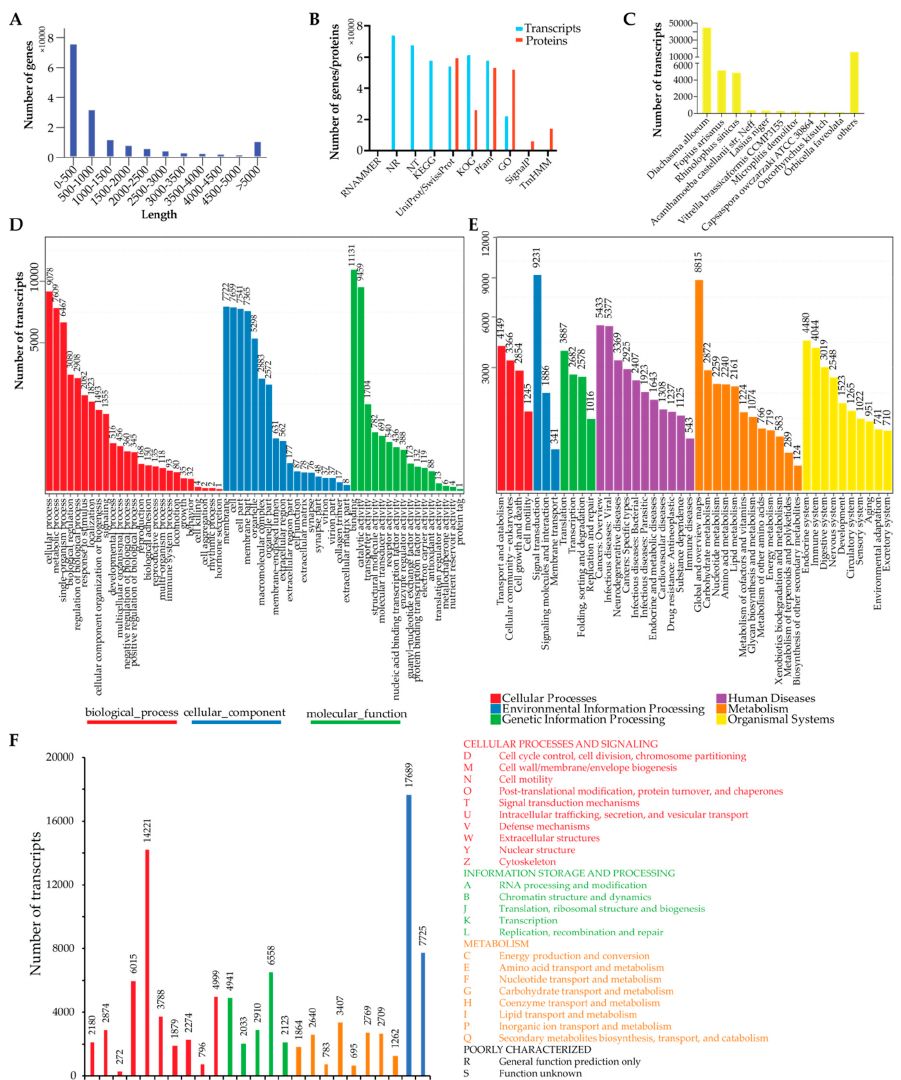
Figure 1. Overview of the assembled Ashmead transcriptome and annotation. ( A ) Length distribution of the assembled Ashmead transcriptome. ( B ) Number of transcripts and likely proteins aligned to different databases. ( C ) Number of the transcripts aligned to other species in the NR mapping results. ( D ) GO annotation for the assembled Ashmead transcriptome. ( E ) KEGG pathway annotation for the